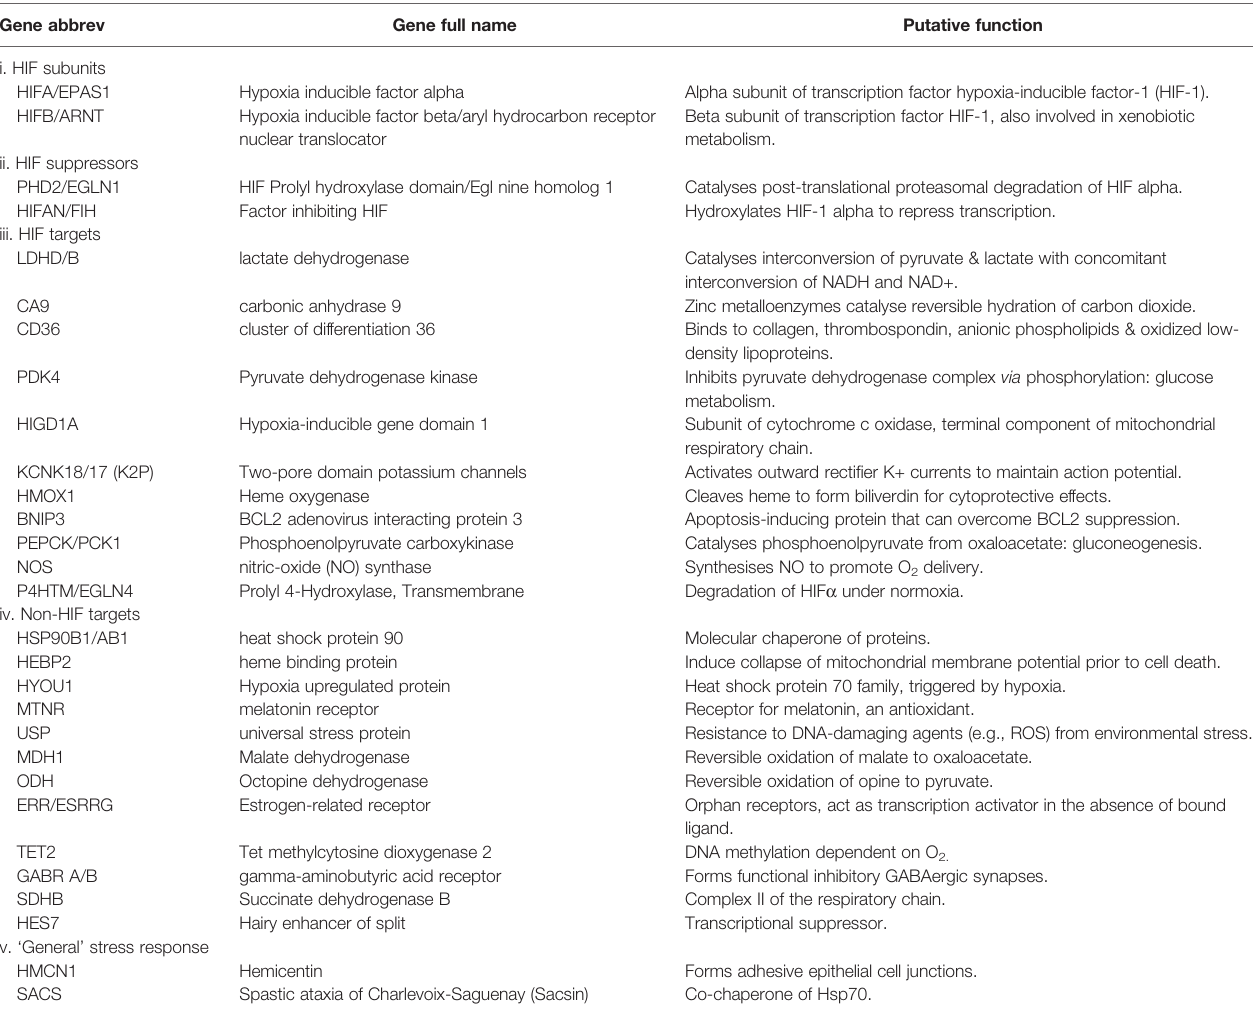
TABLE 2 | Genes of interest (GOIs) associated with the hypoxia stress response. Gene abbrev Gene full name Putative